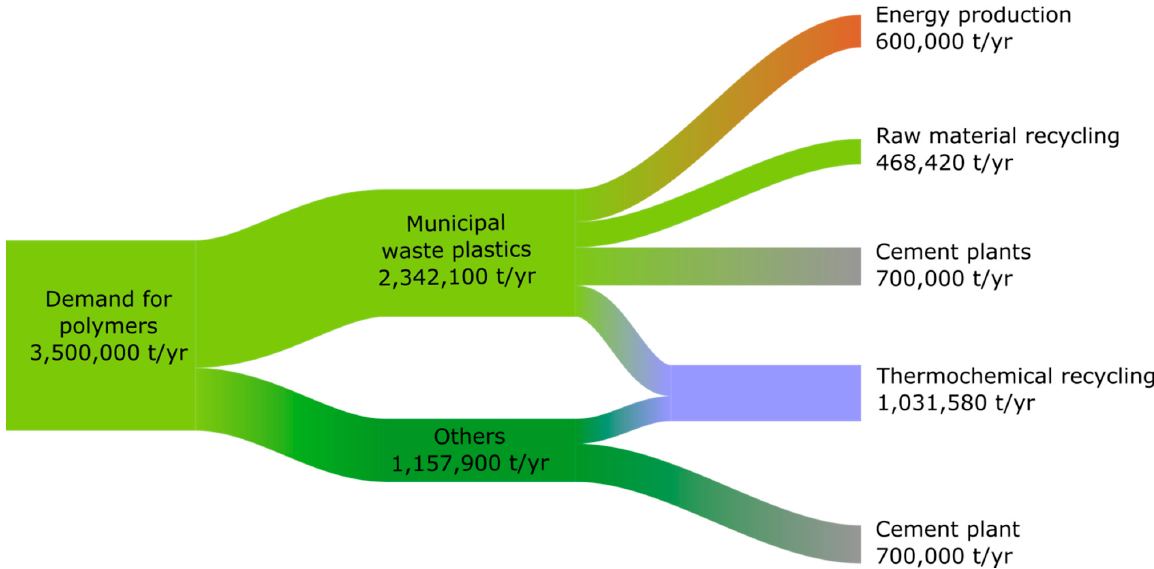
Figure 5. Distribution scheme of plastic waste in Poland, prognosis for 2030.